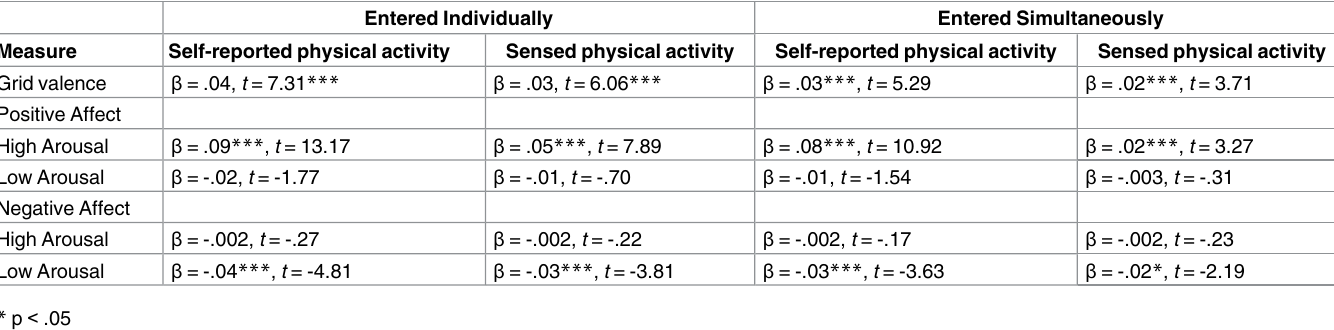
Table 1. Multi-level modelling results predicting affect from physical activity. Degreesof freedom are 2,005 for grid valence,1,996 for higharousalpos- itive affect, 1,975 for low arousal positive affect, 1,958 for high arousal negative affect and 1,958 for low arousal negativeaffect. Entered Individually Entered Simultaneously Measure Sensed physical activity Self-reported physical